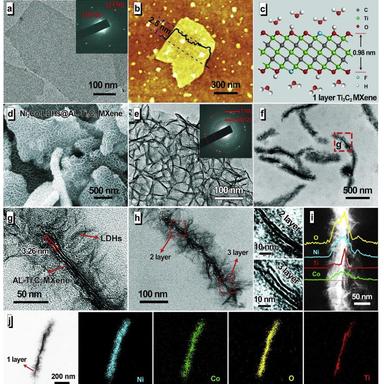
(a) TEM image of an exfoliated AL-Ti3C2 MXene, the inset is the corresponding SAED pattern. (b) AFM image and height information of one exfoliated AL-Ti3C2 MXene. (c) Crystal structure of Ti3C2 MXene monolayer. (d) SEM image of the Ni2Co-LDHs@AL-Ti3C2 MXene composite. (e) Topview TEM image of the Ni2Co-LDHs@AL-Ti3C2 MXene composite, the inset is the corresponding SAED pattern. (f-h) Crosssectional TEM images at low and high magnification. (i) Dark-field scanning TEM image of one Ni2Co-LDHs@AL-Ti3C2 MXene fl